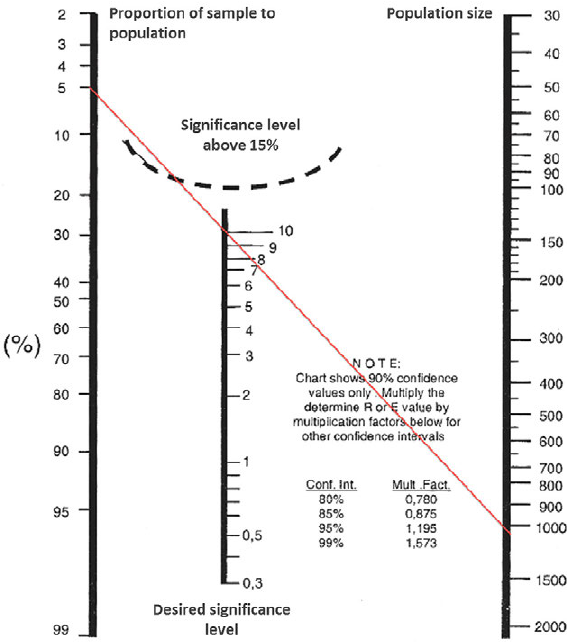
Fig. 1. Harry King’s nomogram acc. to Setyaningrum, Giyarsih